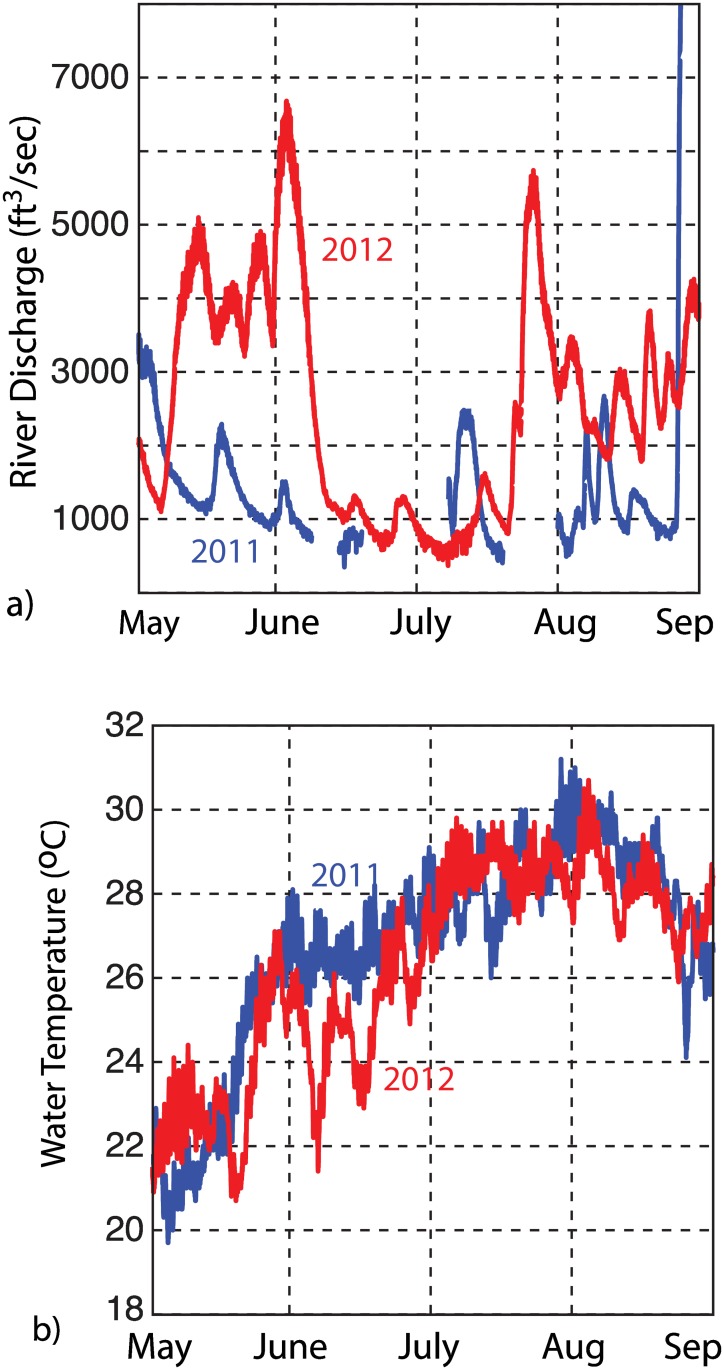
Inter-annual climate variability.Environmental data from Pamlico Sound, NC during the summer of 2011 (blue) and 2012 (red). a) River discharge measured on the Neuse River near Fort Barnwell, NC (35.31°N, 77.30°W). b) Water temperature measured near Beaufort, NC.